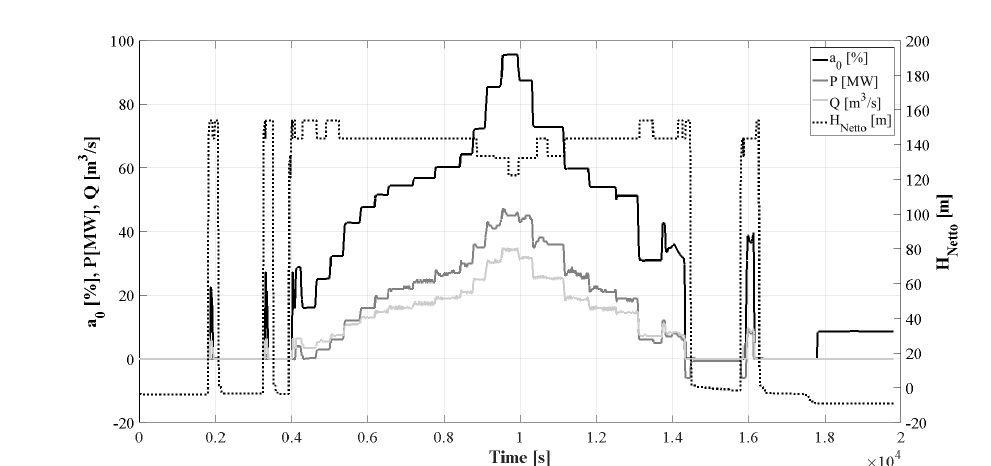
Figure 7. Measurement procedure.